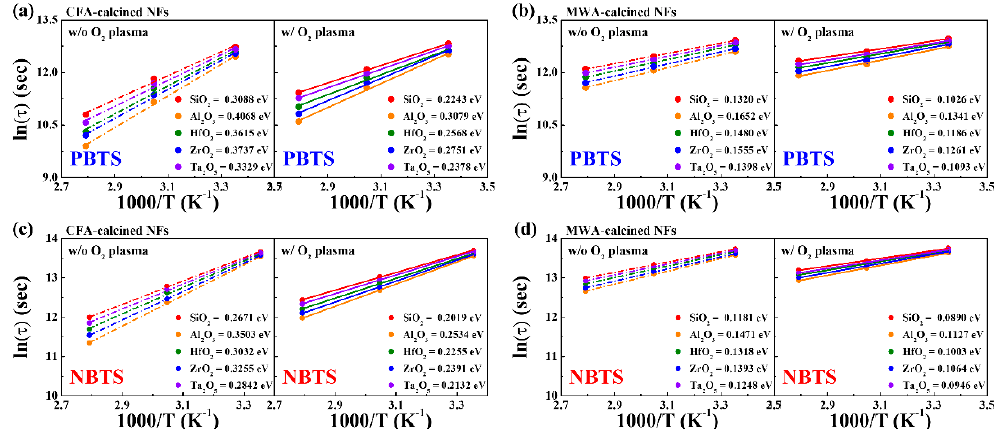
Figure 11. Logarithmic plots of charge trapping time ( τ ) against inverse of temperature (1/ T ) for IGZO NF FETs based on different high- k dielectrics. ( a ) CFA-calcined and ( b ) MWA-calcined devices during PBTS test. ( c ) CFA-calcined and ( b ) MWA-calcined devices during NBTS test. Dashed and solid lines are fitting curves for data obtained before and after postcalcination oxygen plasma treatment, respectively.